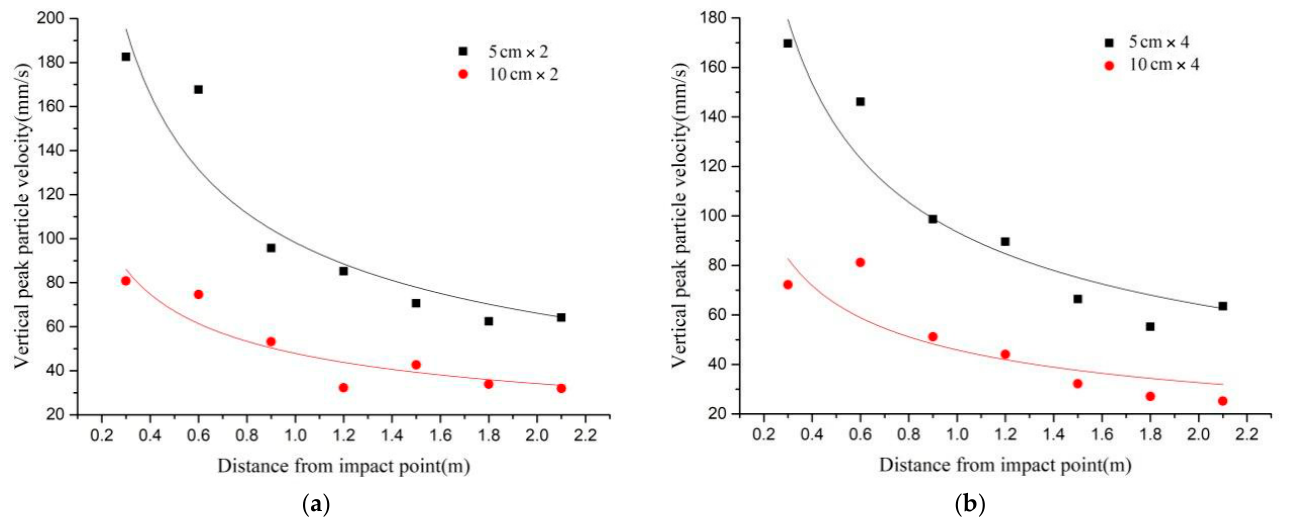
Figure 11. The impact test under the same number but different thicknesses of slabs: ( a ) 5 cm layer thickness double-layer plate and 10 cm layer thickness double-layer plate; ( b ) 5 cm layer thickness four-layer plate and 10 cm layer thickness four-layer plate.